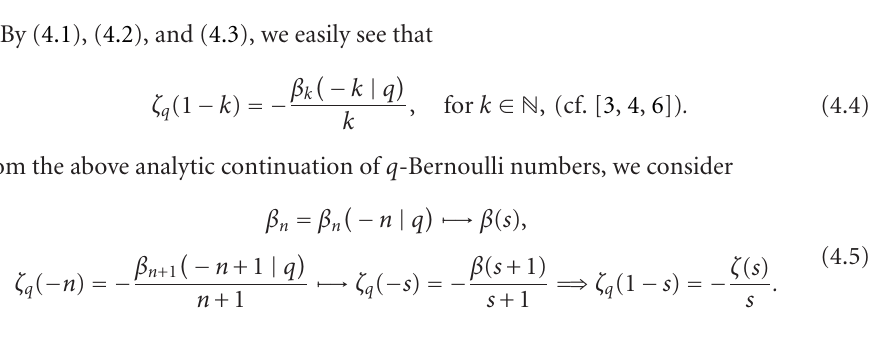
Figure 3.9. The curve of β − n ( n | q ) and lim n →∞ β − n = nζ q ( n +1) = 0, q = 7 / 10, 9 / 10